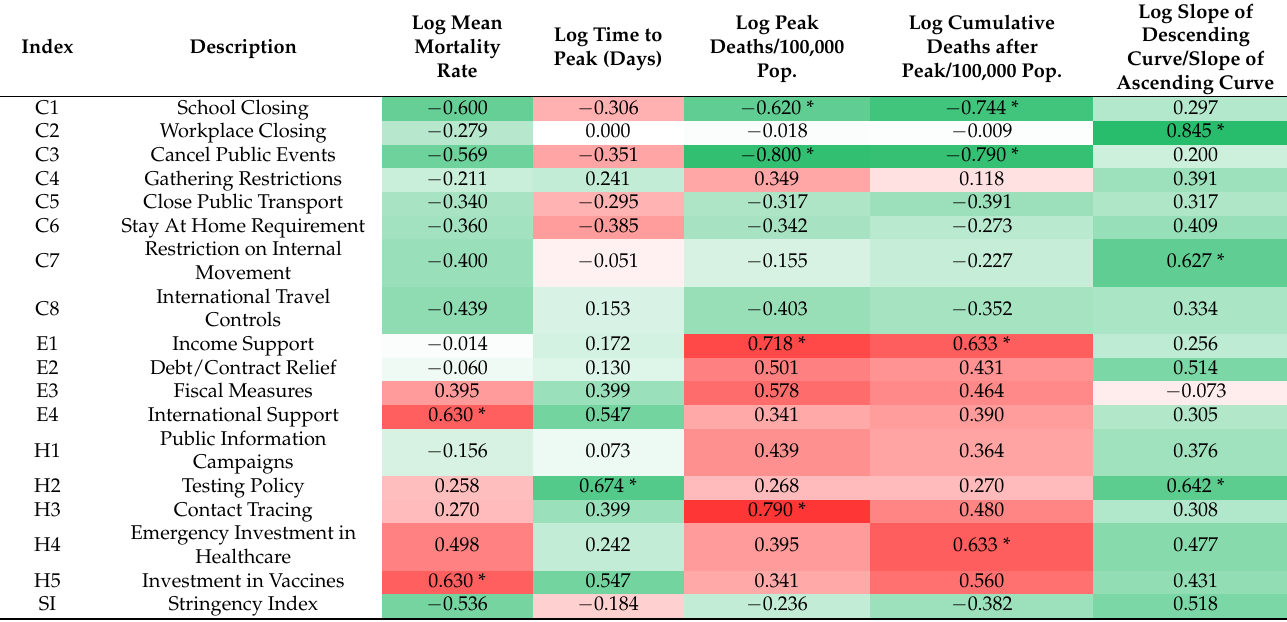
Table 2. Spearman rank-order correlation coefficient of policy indicators and the Stringency Index against five different measures of pandemic severity in the young population based on median country